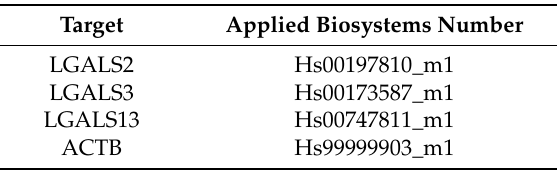
Table 3. Primers and probes used for semi-quantitative mRNA